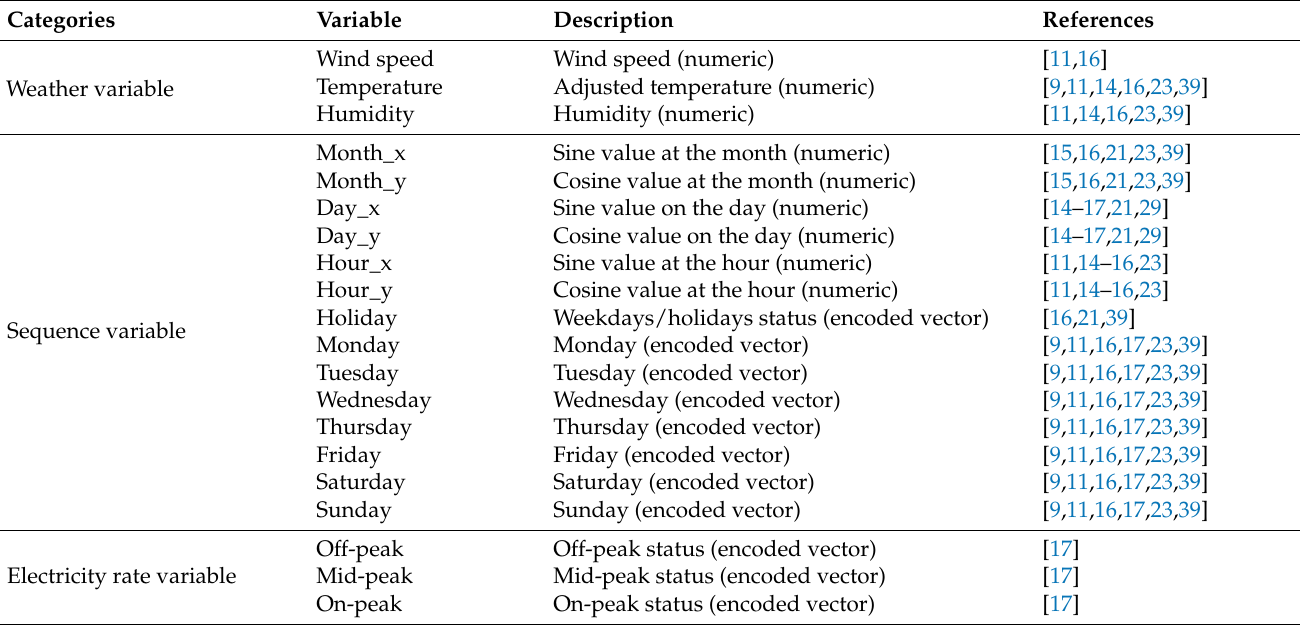
Table 2. Raw data input variable